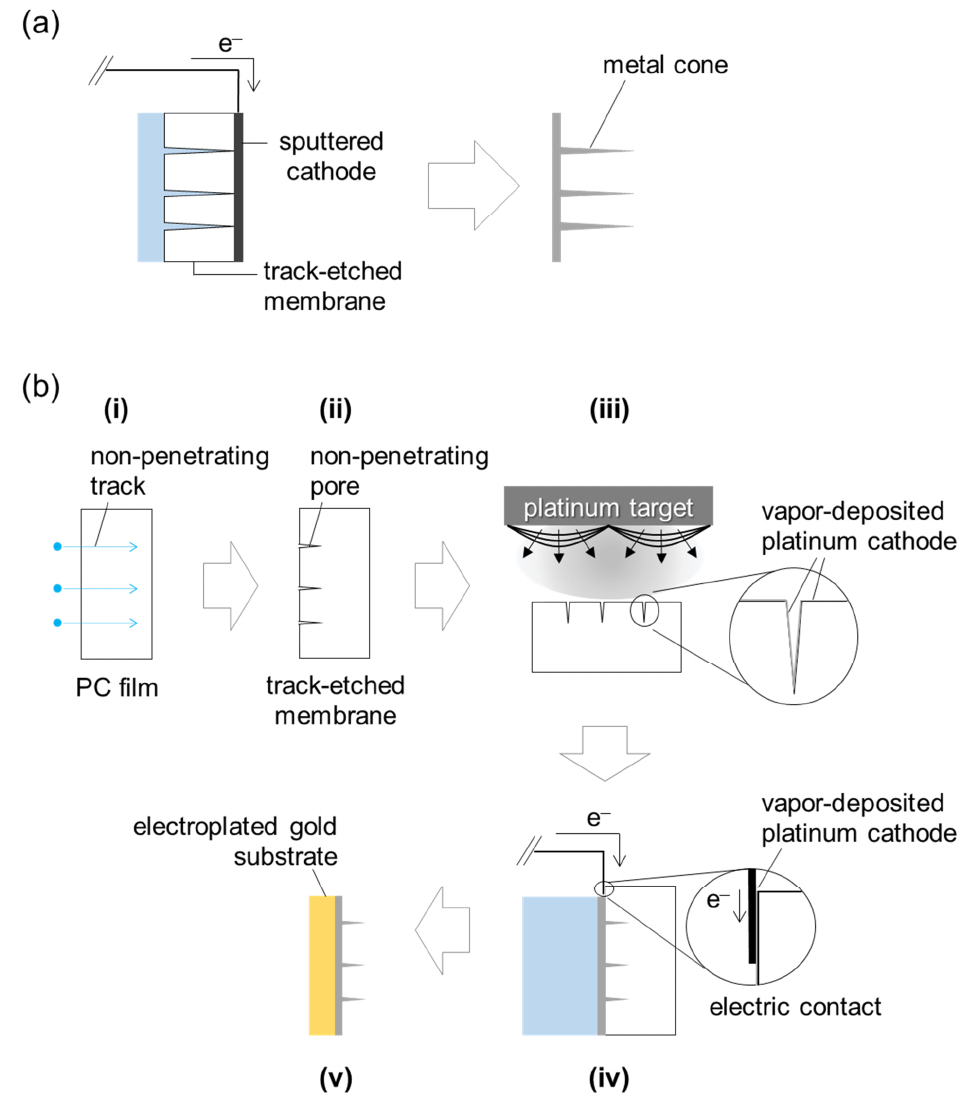
Figure 2. ( a ) Metal cones prepared using the track-etched membranes with penetrating pores as a template, as was the case in most of the previous studies. The conventional method involves sputter-coating with a thin metal layer on one side of track-etched membranes in order to prepare the cathode for electrodeposition. ( b ) Schematics of the main steps in the fabrication of the platinum cones based on a combination of ion-track etching and electrodeposition techniques: ( i ) ion irradiation of a PC film to obtain non-penetrating tracks; ( ii ) asymmetric etching to form non-penetrating conical pores; ( iii ) vapor deposition of a thin platinum layer from the pore-open side as a cathode; ( iv ) electrochemical deposition of platinum from the bottom of the non-penetrating pores, and from the surface of the track-etched membranes; ( v ) free-standing platinum cone array after reinforcement with a thick electroplated gold substrate and the removal of the tem- plate.